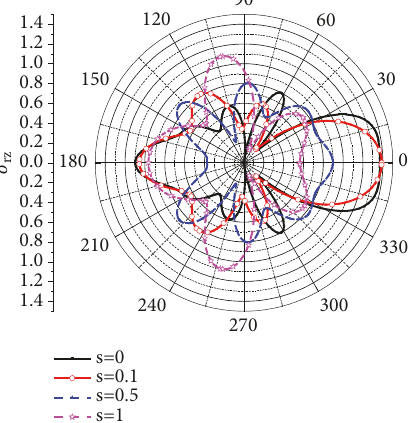
Figure 9: Effect of interface effect on the radial stress with 𝐾 𝐼 /𝐾 = 𝜋 .